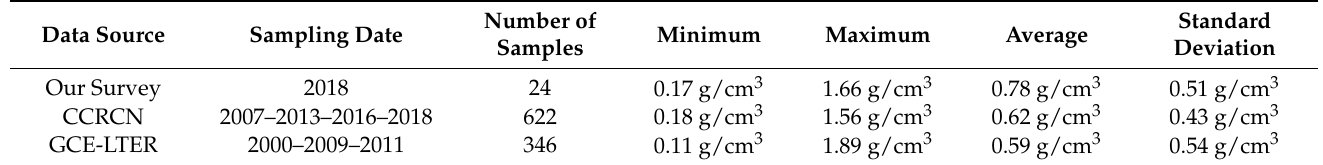
Figure 1. Flowchart illustrating the steps for soil bulk density prediction using Landsat-7 ETM+ data. Table 1. General statistical description of the dataset.